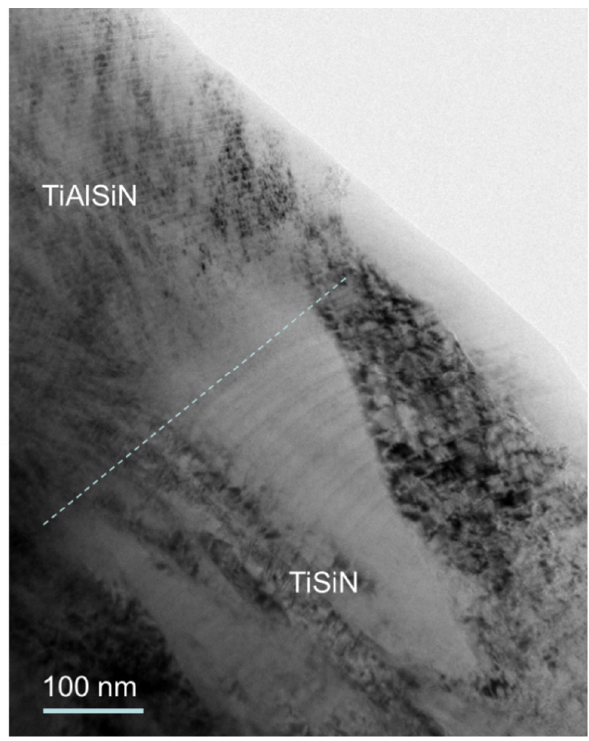
Figure 2. Cross-sectional TEM image of nanocomposite TiSiN and nanolayer TiAlSiN layers in »TiAlSiN« hard coating [27].